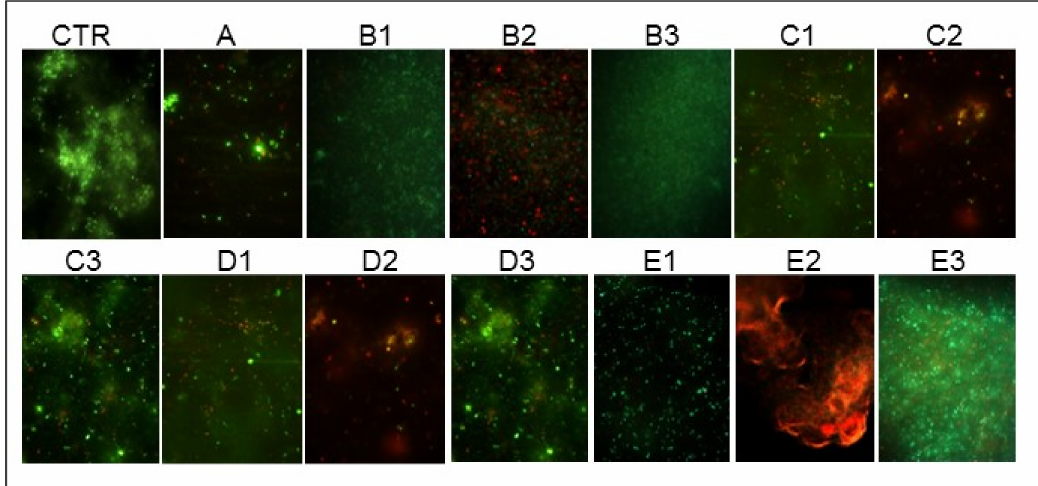
Figure 3. Representative live/dead images of untreated (CTR) and treated LCWBs. For the experi- mental points, see Figure 1 and the Section 4, paragraph 5.